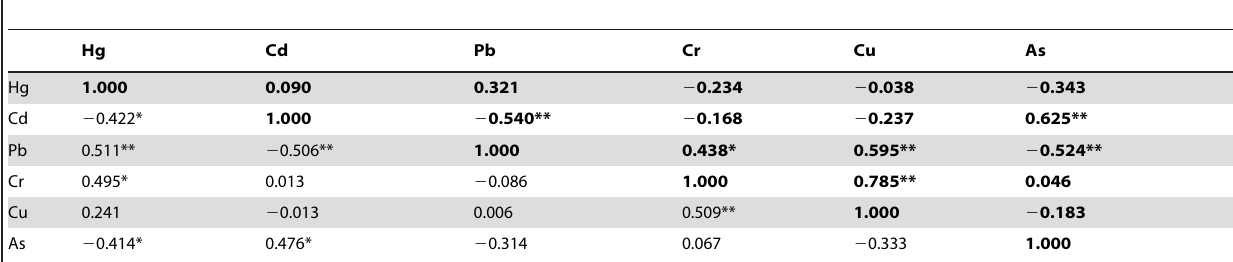
Table 4. Correlations between heavy metals in surface sediments from the Hongfeng and Baihua